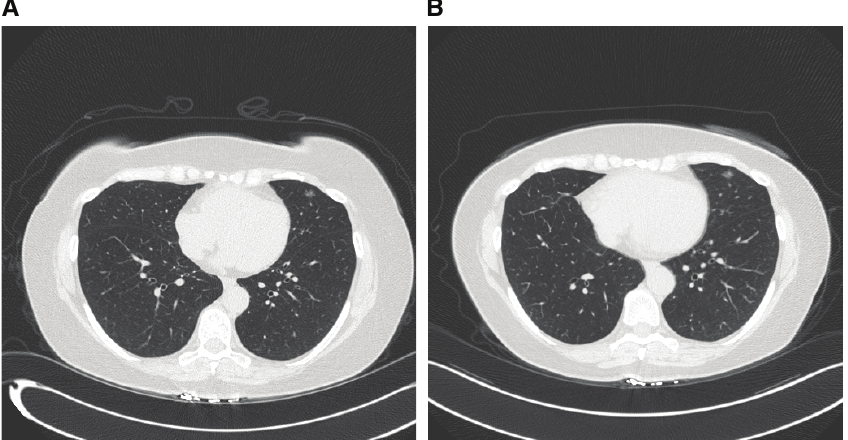
Figure 2. A 67-year-old woman, former smoker with a 9 mm ground glass opacity (GGO) in the lingula. The nodule has changed minimally over 3 years and is currently being followed with annual computed tomography (CT). If this is a cancer, it is likely to be an adenocarcinoma in situ and may represent an overdiagnosis